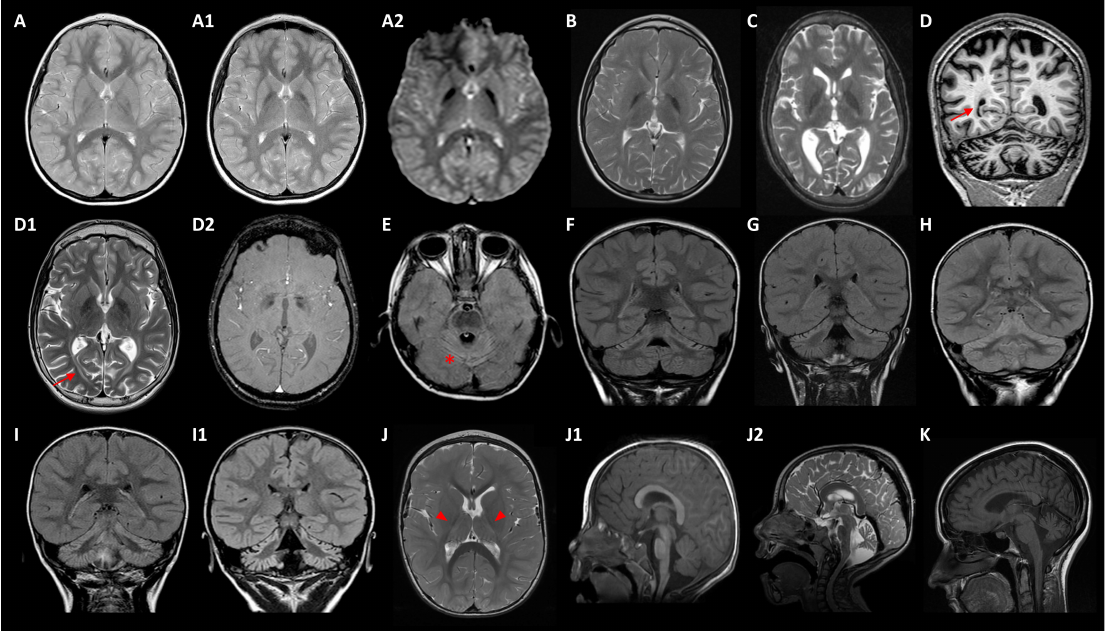
Figure 2. Main neuroimaging features. ( A – A2 ) MD-020/ GLB1 : axial TSE (turbo spin echo) T2 weighted image at ages 6 ( A ) and 11 ( A1 ) showing progression of globus pallidus (GP) hypointensities, demonstrating iron deposition in axial T2* GRE (gradient echo) image ( A2 ) at 11 years old. ( B ) MD-137/ FUCA1 and ( C ) MD-153/ TPP1 revealing T2-weighted images (T2WI) GP hypointensities at ages 10 and 14, respectively. ( D – D2 ) MD-189/ KIF1A at 17 years old: coronal T1-weighted image showing cerebral and cerebellar atrophy ( D ), axial T2WI revealing GP hypointensity ( D1 ) and SWI, susceptibility weighted imaging ( D2 ) showing iron deposition; the patient also presented periventricular and deep white matter abnormal signal (arrows). ( E ) MD-200/ KIF1A at age of 4: axial FLAIR (fluid attenuated inversion recovery) image revealing global cerebellar atrophy with cortical hyperintensity (* tram-track sign). ( F – H ) Coronal FLAIR images uncover predominantly upper cerebellar cortical hyperintensity in patients MD-106 at age of 3 ( F ), MD-041 of 4 ( G ), and MD-320 of 4 ( H ), with ITPR1 variants. ( I – I1 ) MD-323/ PMPCA : Coronal FLAIR images at 2 years old ( I ), and at 8 years old ( I1 ) demonstrating progression of cerebellar atrophy with cortical hyperintensities. ( J – J2 ) MD-181/ PLEKHG2 from 2 ( J , J1 ) to 5 years old ( J2 ): T2WI ( J ) showing thalamic and posterior internal capsule hyperintensities (head arrows), and mild deep white matter hyperintensity; mid-sagittal T1 weighted image ( J1 ) and midsagittal T2WI ( J2 ) demonstrating progression of cerebellar atrophy. ( K ) MD-270/ HEXA : mid-sagittal T2WI revealing cerebellar atrophy at disease onset (23 years